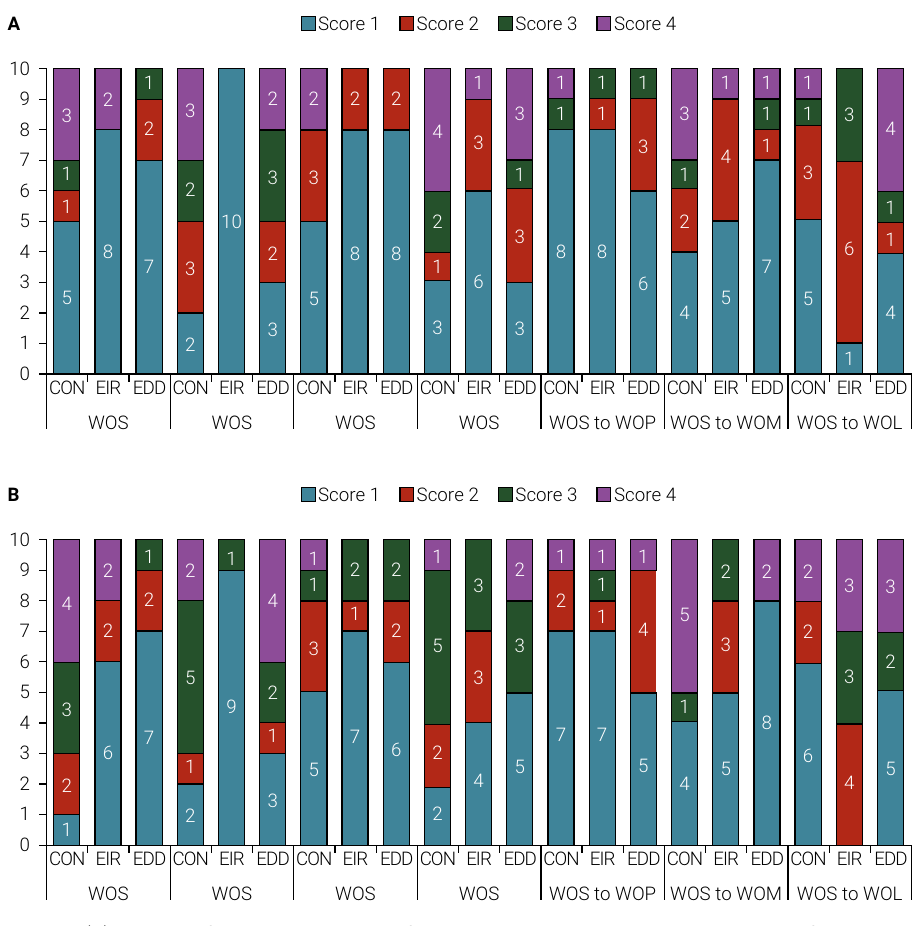
Figure 2. (A) Number of specimens recorded for each score in relation to the apical third of root canals in the evaluation of residual debris of the different treatments (100×), and (B) smear layer (1000×). WOS, WaveOne Gold ® Small; WOP, WaveOne Gold ® Primary; WOM, WaveOne Gold ® Medium; WOL, WaveOne Gold ® Large; CON, control group; EIR, E1 Irrisonic ® ; EDD, EDDY ®